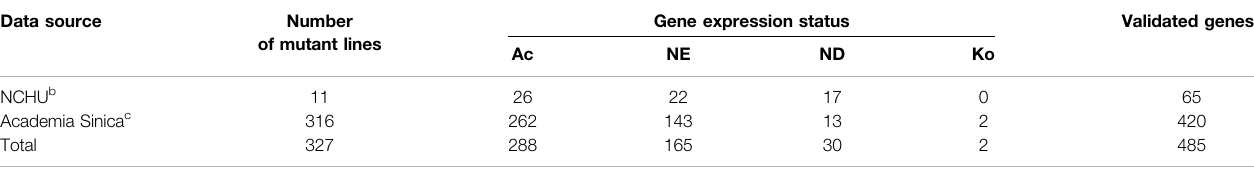
TABLE 1 | Data distribution of fl anking analyzed genes in rice T-DNA mutants.